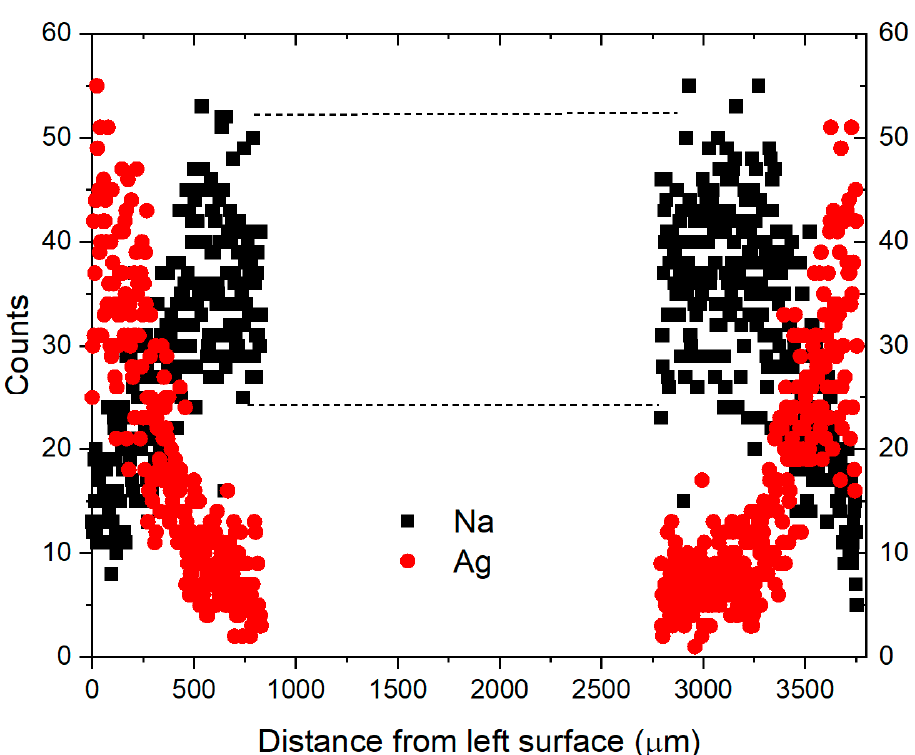
Figure 3. EDS line scans of a sample ion-exchanged in AgNO 3 at 300 °C for 1 h. The “left” surface was arbitrarily chosen from one of the planar surfaces of a disc sample.